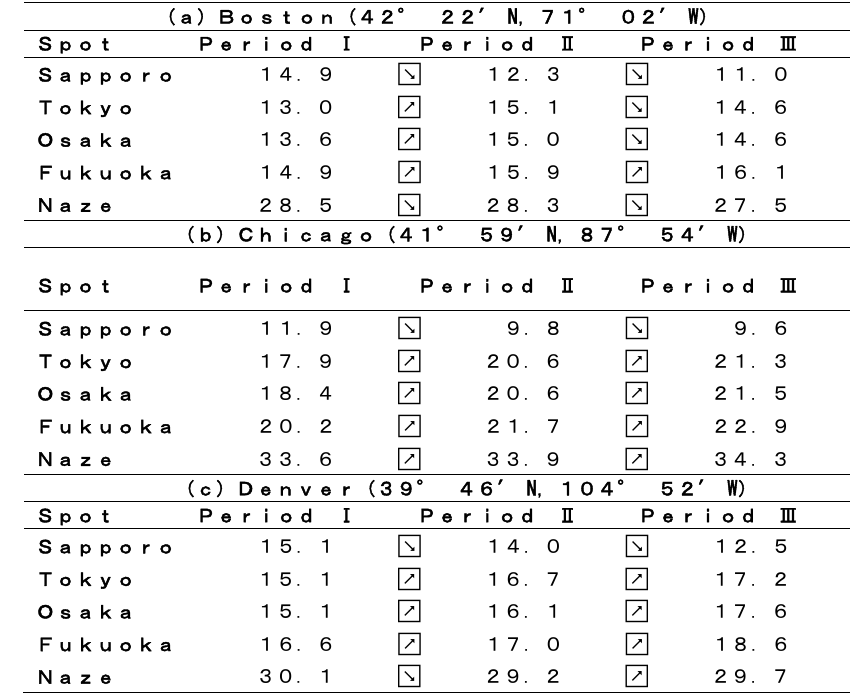
Table 7. The sequence of the cross angle of the monthly distributions of temperatures between three North-American and five Japanese stations.